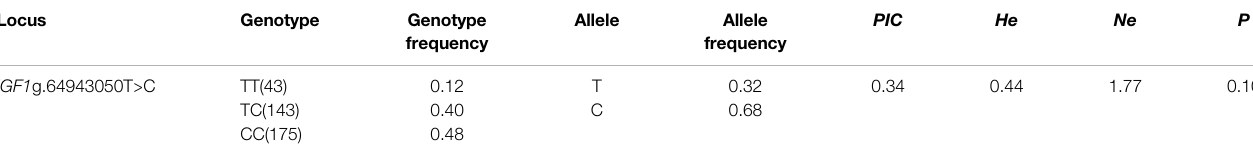
TABLE 2 | Population polymorphism analysis of locus in goat. Locus